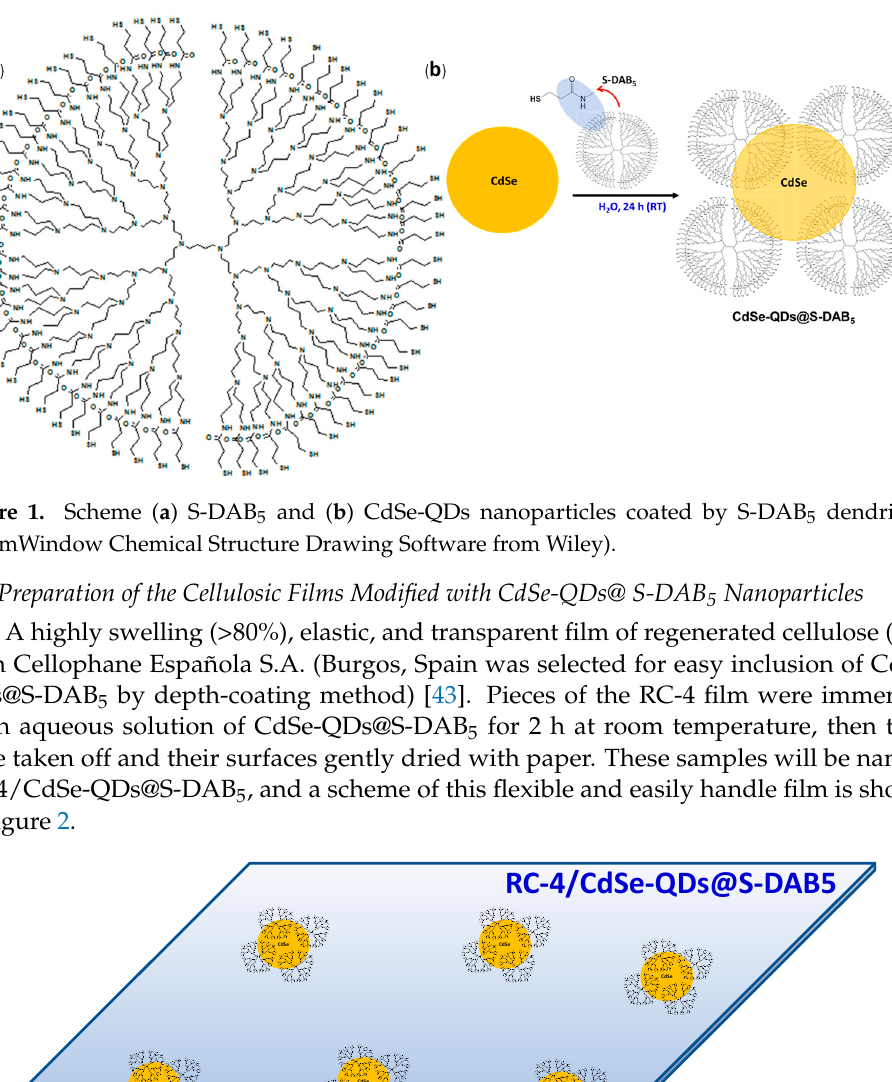
Figure 2. Scheme of the RC-4/CdSe-QDs@S-DAB 5 film.